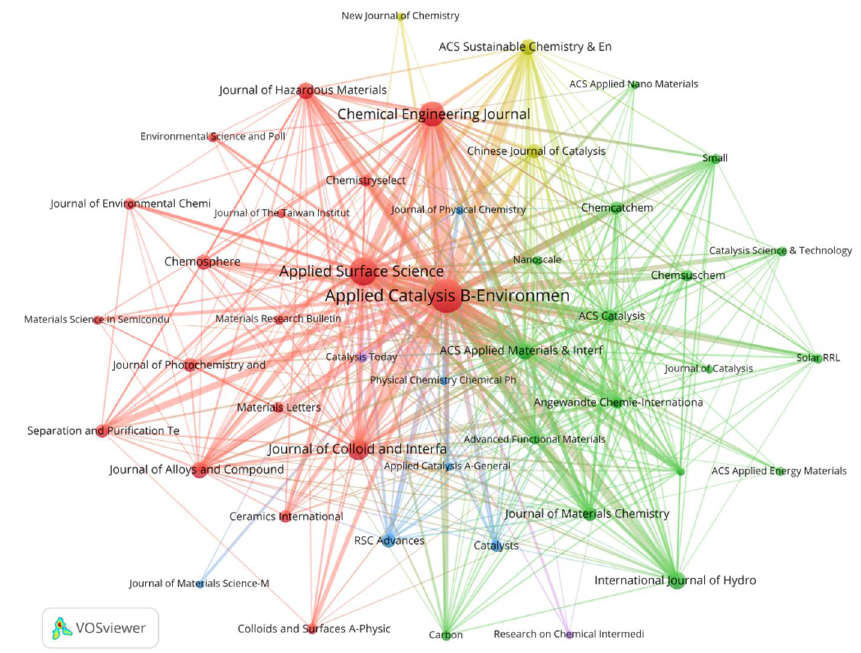
Figure 4. Top publication number network of photocatalytic applications of g-C 3 N 4 .